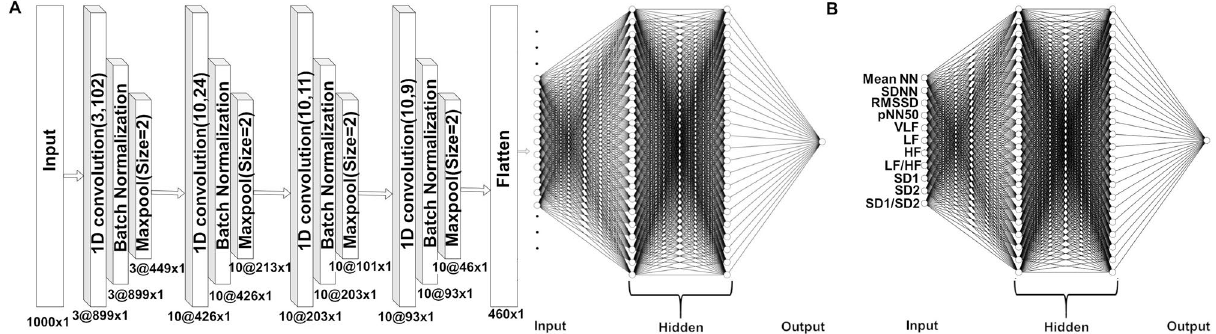
Figure 1. ( A ) CNN architecture with an input layer, four hidden layers, and a flatten input that will be fed to dense layers. (1D: one dimension) ( B ) The architecture of our